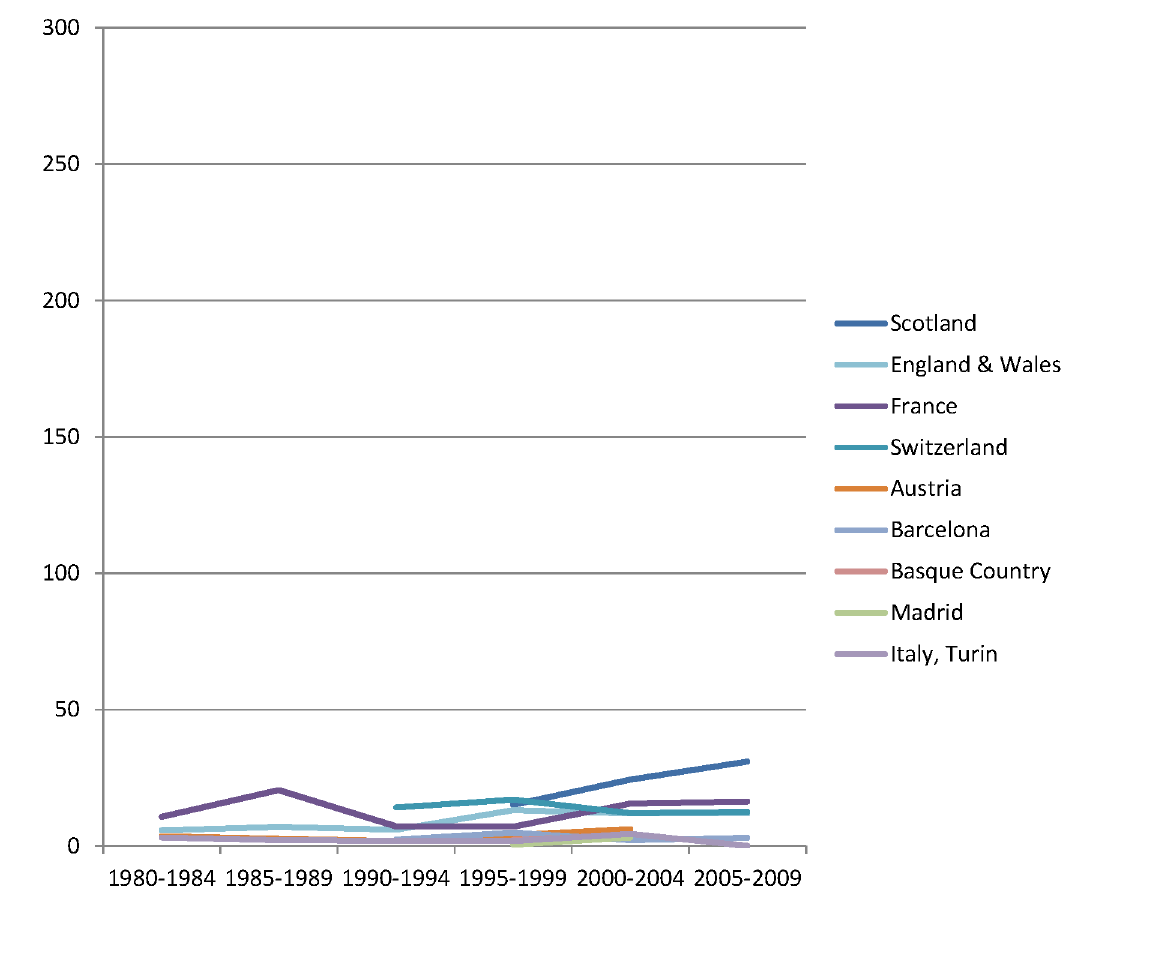
Fig 5. Trends in age-adjusted mortality from alcohol-related causes among men aged 35 – 79 y in the high education group in Western and Southern European countries/regions, ca. 1980 – 2010, by country/region. The y- axis shows age-adjusted alcohol-related mortality in deaths per 100,000